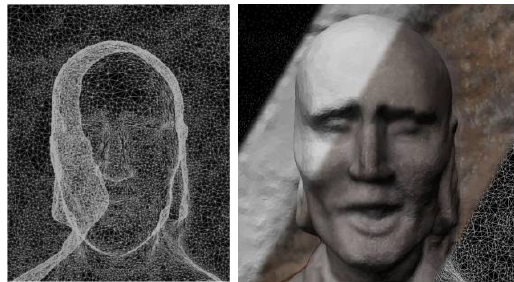
Fig.2 different point space-different